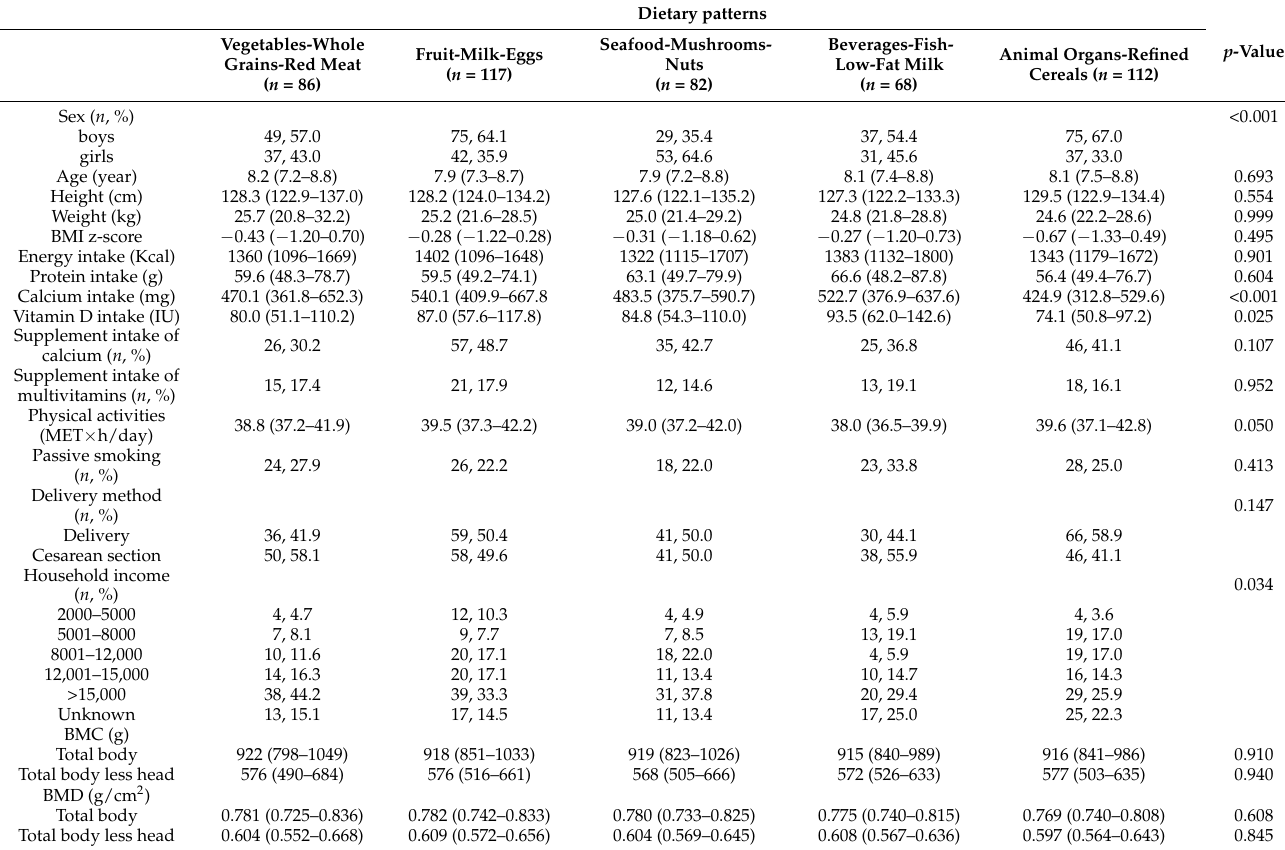
Table 1. Baseline characteristics in participants divided by dietary patterns *. Dietary